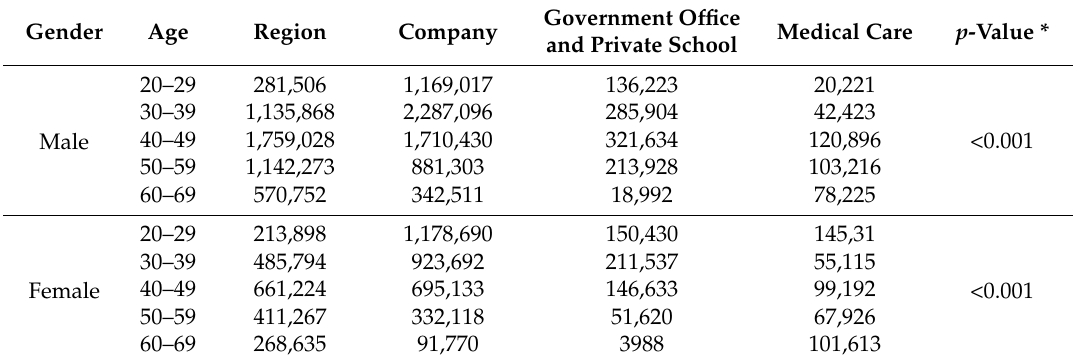
Table 1. Mean number of subscribers according to gender, age and health insurance eligibility (2004–2010)